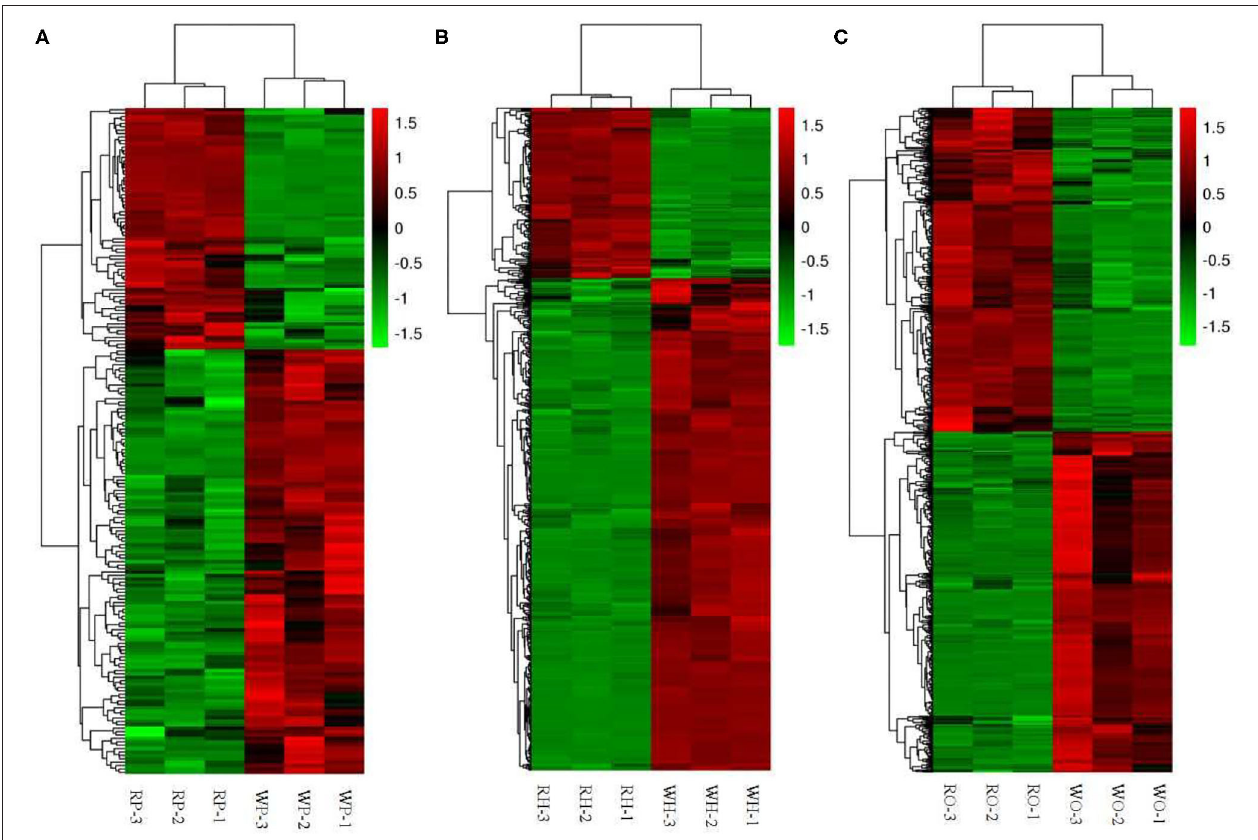
FIGURE 3 | Cluster thermogram of differential metabolites. (A) pituitaries, (B) hypothalamus, (C) ovary.